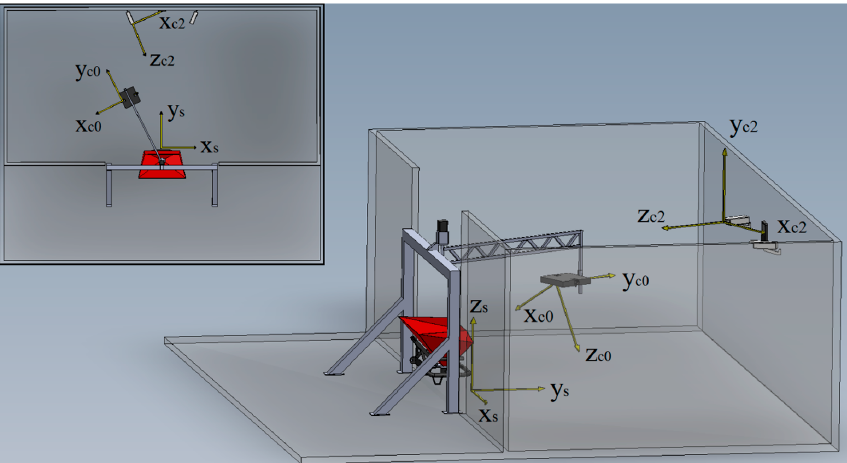
Figure 1. Developed setup for determining spread patterns of centrifugal fertilizer spreaders (3D view and top view). Two cameras and a LED illumination system were attached to a rotatable arm. The arm was attached to a frame under which a spreader was placed. A second set of cameras was attached to the wall of the setup. The spreader coordinate system (x s , y s , z s ) and camera coordinate systems of camera 0 (x c0 , y c0 , z c0 ) and camera 2 (x c2 , y c2 , z c2 ) are